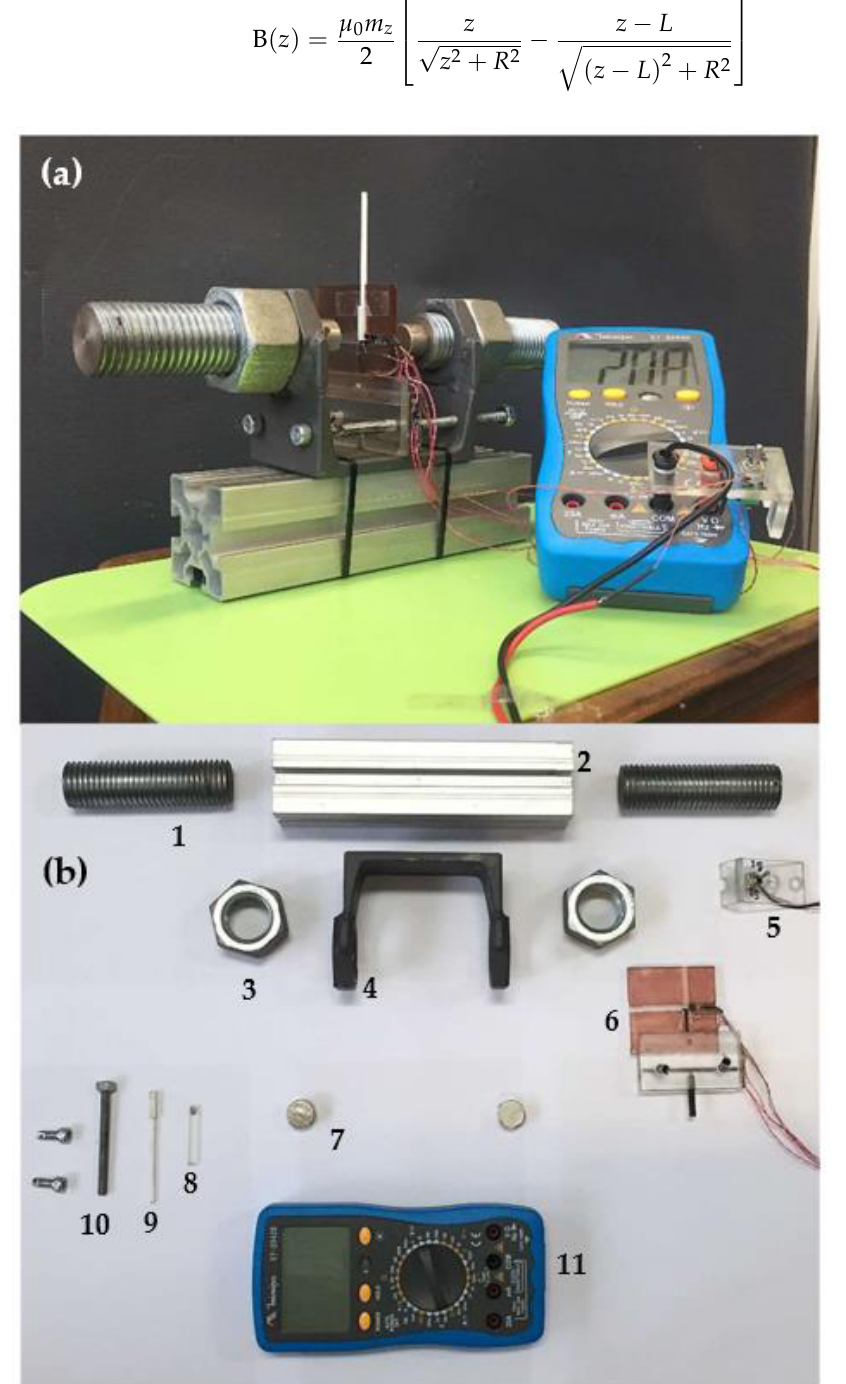
Figure 3. ( a ) The developed magnetometer. ( b ) Components of the magnetometer: 1 base for holding the magnets in a cylindrical shape, 30 mm diameter and approximately 109 mm long, 2 aluminum base of 45 × 45 mm and 22 cm length, 3 two iron threaded nuts, 4 fixed iron structure to fix the probe Hall, 5 device built to activate sensors S1 and S2, 6 probe Hall, 7 cylindrical neodymium magnet of 32 mm diameter and 25 mm length, 8 and 9 sample holder, acrylic plates of 5.2 × 3.1 × 32, 10 screw used to align the probe Hall with the magnetic field applied by the magnets, 11 multimeter. The AD-AD22151 Hall effect sensor was calibrated to maximum sensitivity (110